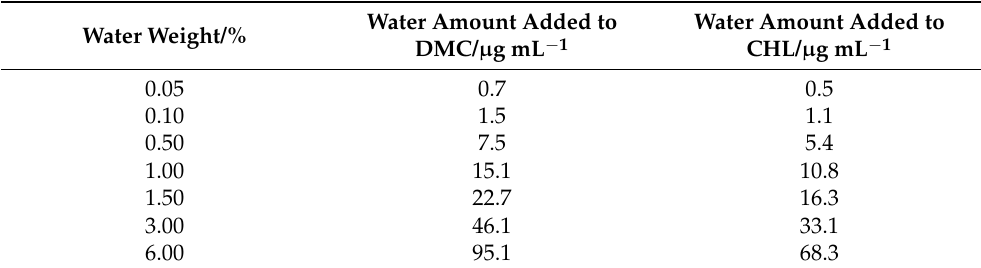
Table 1. Water weight percent of samples measured to evaluate water-in-solvent vesicle size and amounts of water ( µ g mL − 1 ) added to the selected